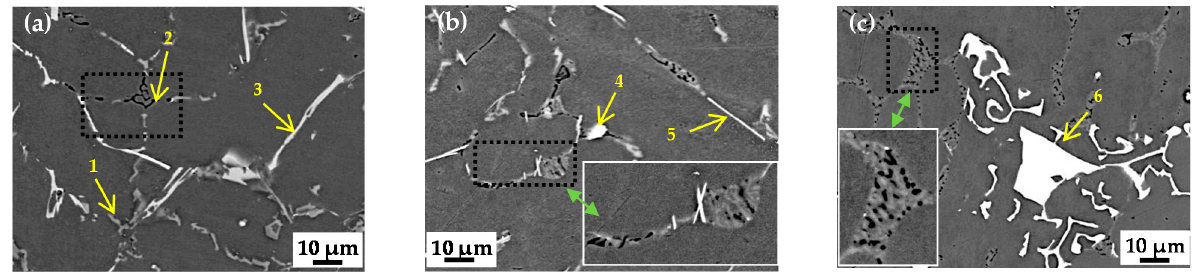
Figure 4. SEM images of Al-5Si-0.8Mg alloy ingots ( a ) without Mn and those with ( b ) 0.45% Mn and ( c ) 1.09% Mn.